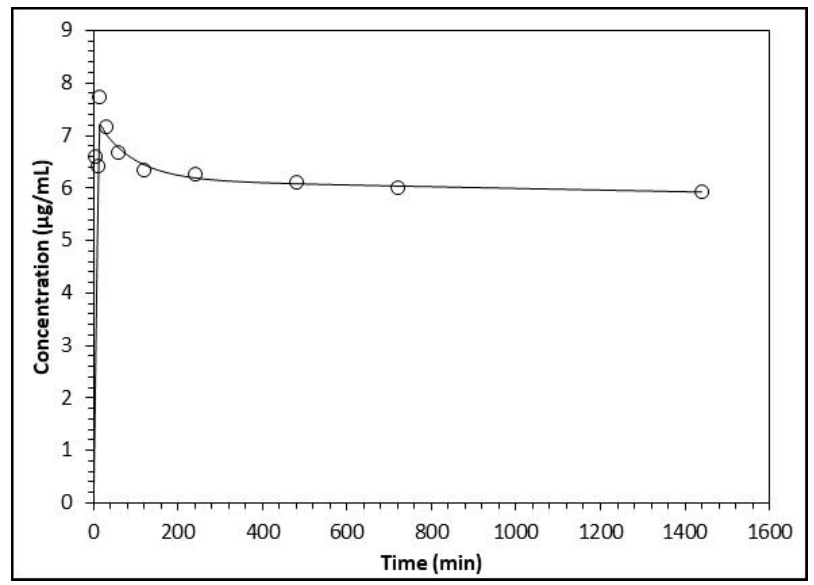
Figure 5. Analysis of the variation of plasma concentration of DOPAC (open circles) with respect to the time in minutes. The line represents the prediction of the behavior of the concentration following a two-compartment model.